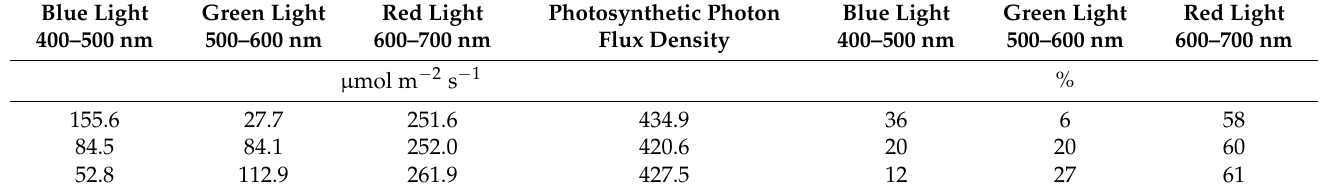
Table 1. Spectral characterization of LED lamps and the blue, green and red light balance.